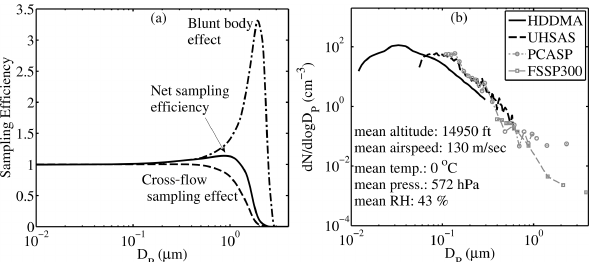
Figure 11. (a) Model-predicted sampling efficiency for BASE-II; (b) measured aerosol size distribution from BASE-II compared with the free-stream measurements in clear air. Measurement data from ICE–Trf04 (11 July 2011, 17:39:00–17:49:30UTC). HDDMA